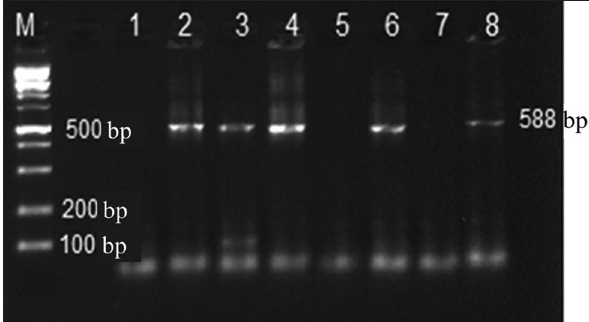
Figure-1: The polymerase chain reaction results of the p32 gene of infectious laryngotracheitis virus (ILTV) are shown in four samples at 588-bp fragment. M=100-bp DNA ladder; 1=Negative control; 2=Positive control (ILTV reference strain); 3-8=field strains isolated.